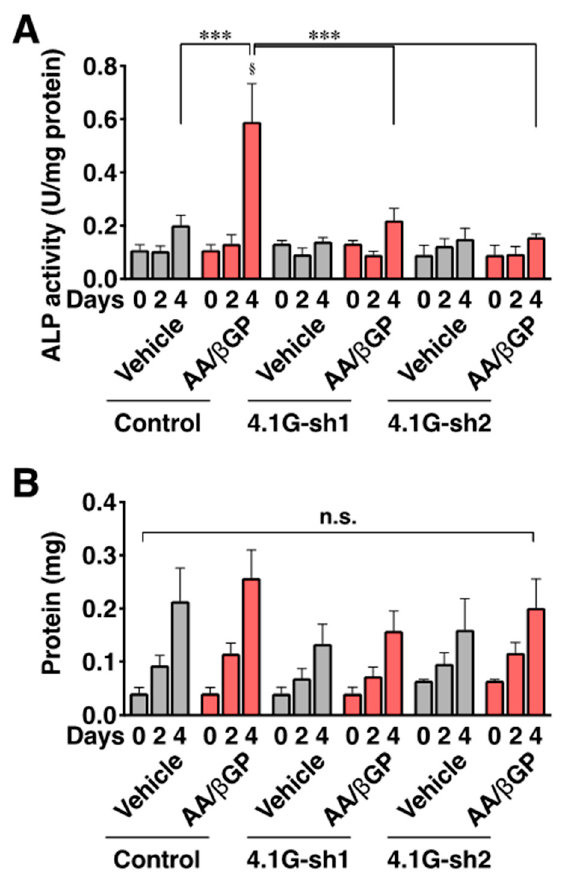
Figure 6. Protein 4.1G supports osteoblast differentiation in MC3T3-E1 cells. MC3T3-E1 cells trans- fected with the control or 4.1G-sh1 were treated with AA/ β GP for 2 and 4 days. ( A ) Alkaline phosphatase (ALP) activity in the cell lysate was measured. The activity was normalized by the protein content. ( B ) Protein content in the whole cell lysate was measured at the indicated time points. Data are presented as the mean ± S.E.M. from five independent experiments. § p < 0.05, one-way ANOVA followed by Tukey’s test (vs. Day 0 of the group). *** p < 0.001, two-way ANOVA followed by Bonferroni’s test. n.s., not significant.